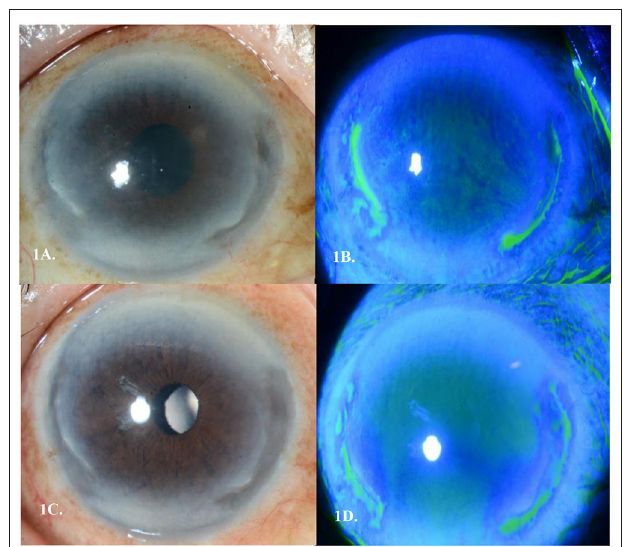
FIGURE 1 | (A) Peripheral ulcerative keratitis (PUK) seen in Case 1’s right eye with 2 discrete areas of severe peripheral corneal melt spanning 2 clock hours nasally and 2 clock hours temporally (B) . Corresponding staining of areas of cornea melt temporally and nasally (C) . Epithelization over the two areas of cornea melt by day 9 of treatment (D) . Corresponding area of pooling temporally and nasally showing epithelization of the stromal melt.